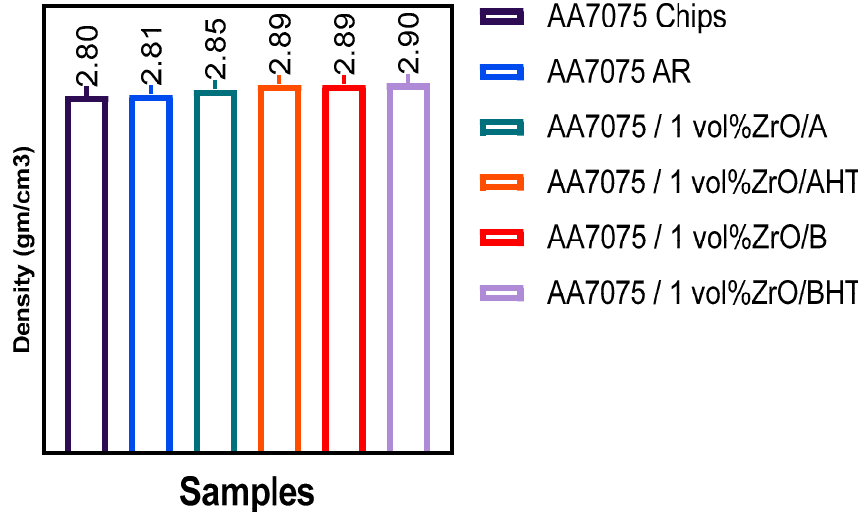
Figure 12. The results of density.